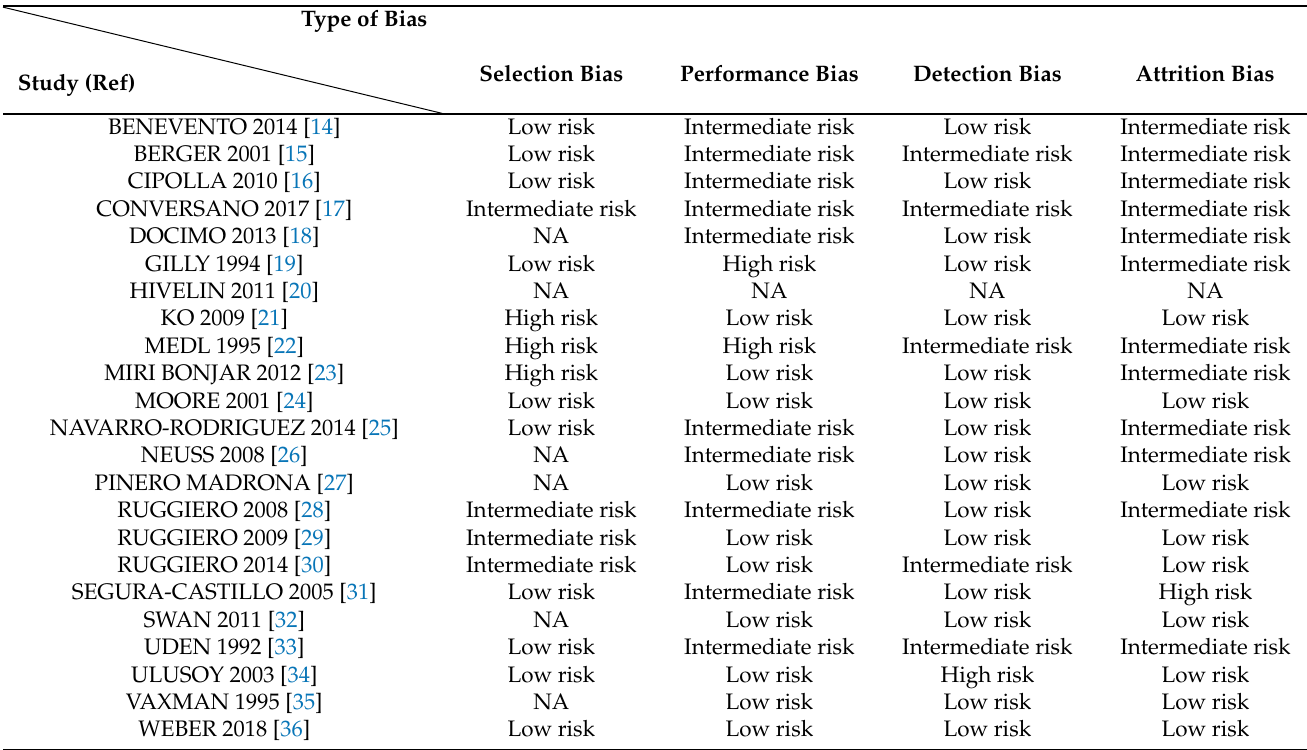
Table 3. Risk of bias assessment.